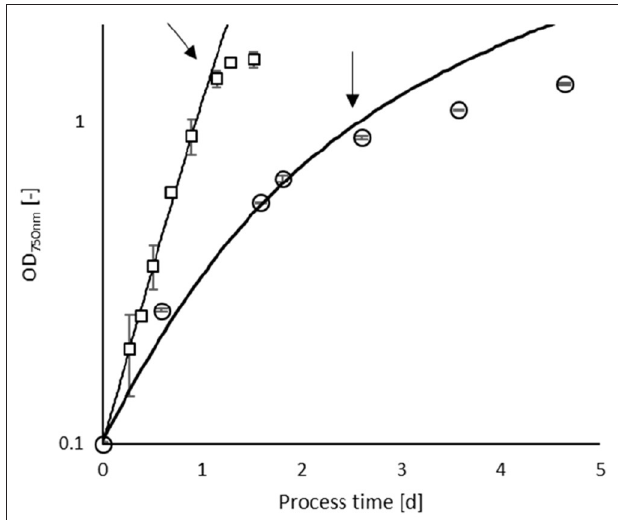
FIGURE 1 | Culture development of Arthrospira platensis (open circles) cultivated at 35 ◦ C and 180 µ mol m − 2 s − 1 and C. asymmetrica (open squares) at 30 ◦ C and 1,429 µ mol m − 2 s − 1 . The error bars indicate the standard deviation of three independent measurements. The solid lines indicate the simulation of the growth behavior. The arrows indicate the beginning of the stationary phase, where sampling was carried